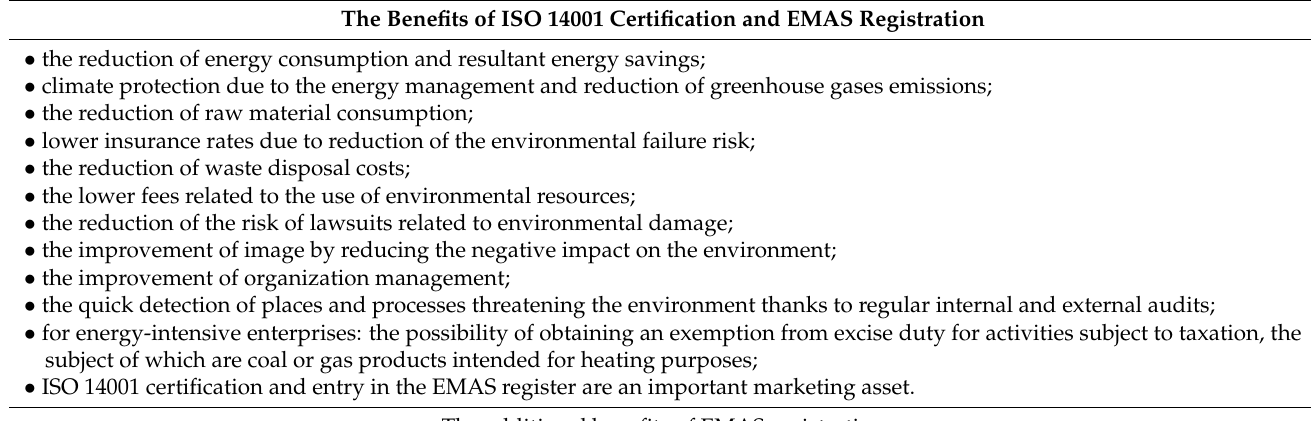
Table 2. The selected benefits of ISO 14001 certification and EMAS registration. Source: Own elaboration based on